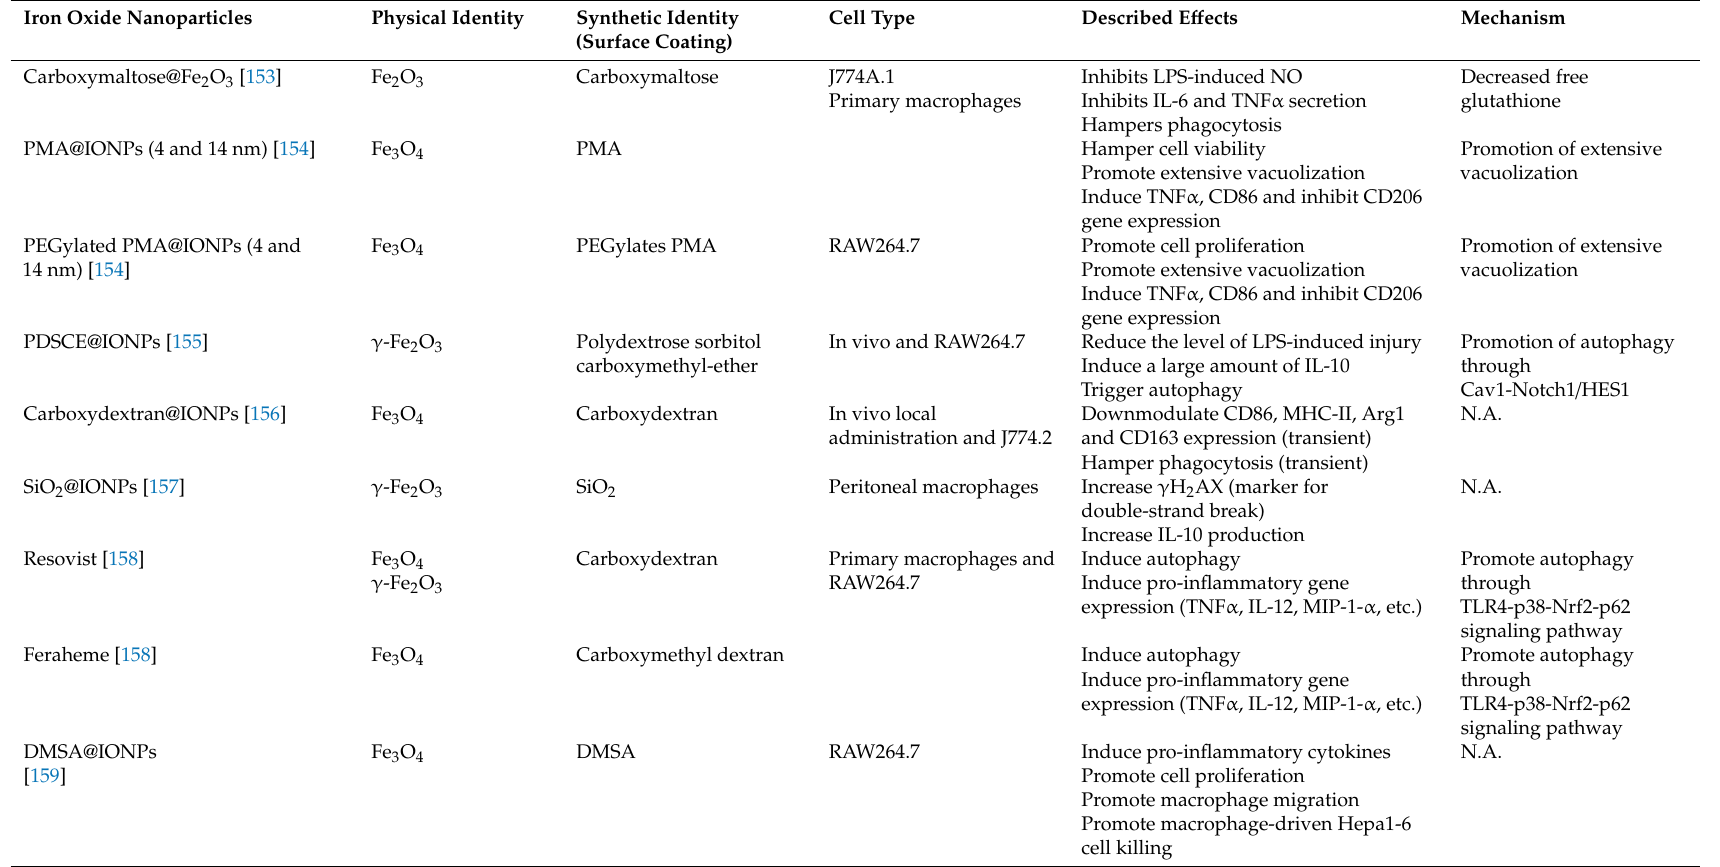
Table 4. A list of IONPs recently investigated for their e ff ect on the